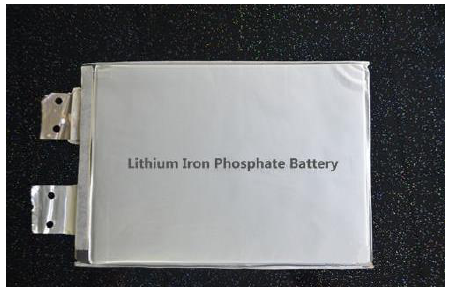
Figure 1. Test sample of lithium iron phosphate (LFP).